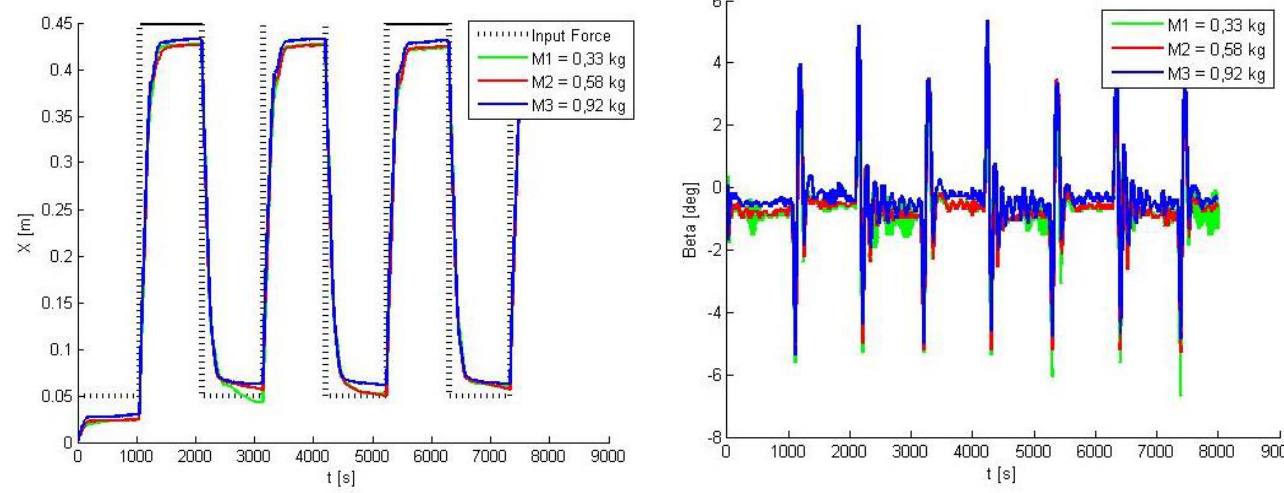
Fig. 12. Anti-swing 5DOF fuzzy logic regulator X -axis position simulation results.